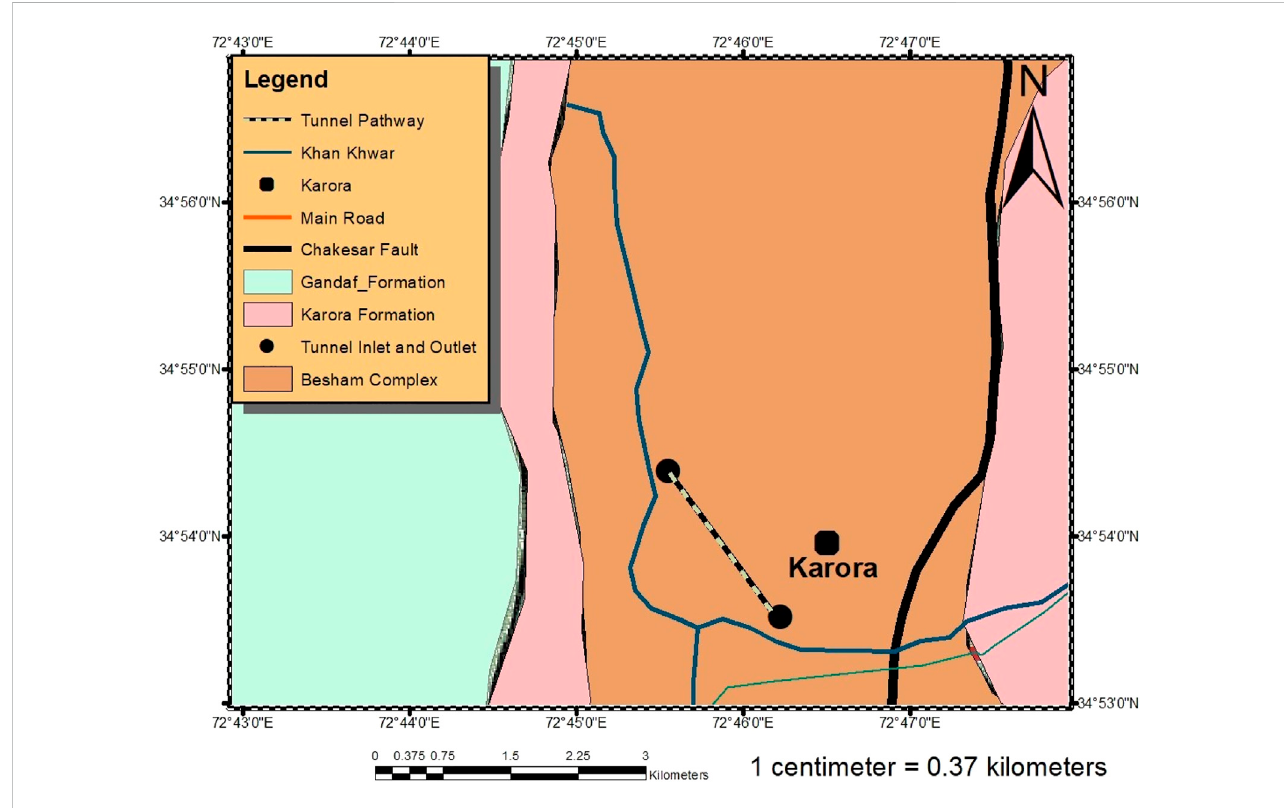
FIGURE 2 Detailed geological map of the study area modi fi ed after Hussain et al.